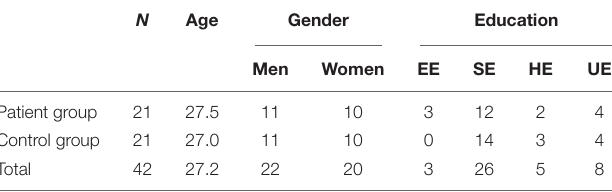
TABLE 1 | Demographic variables of patient and control